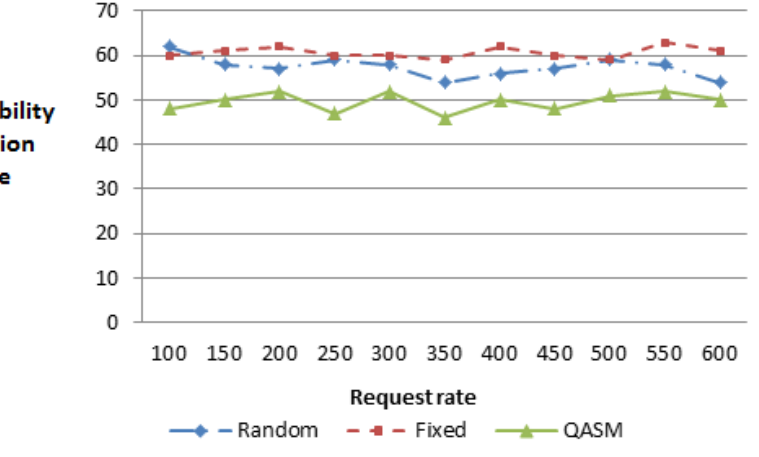
Figure 5. Average availability QoS deviation rate under different system load